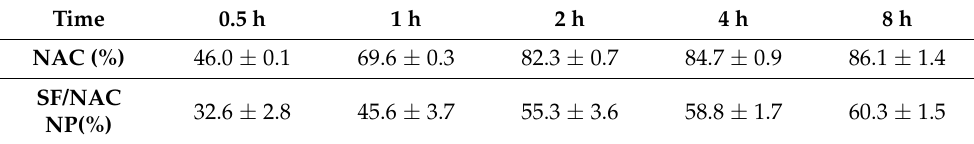
Table 1. The cumulative release of NAC for SF/NAC NPs (n = 4).